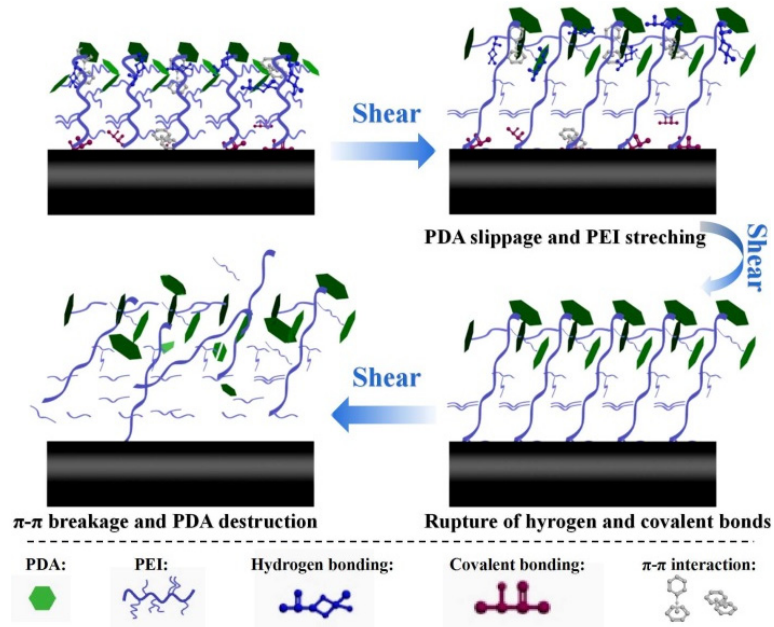
Figure 8. Schematic diagram of toughening mechanism of CF-PEI-PDA/EP composite.